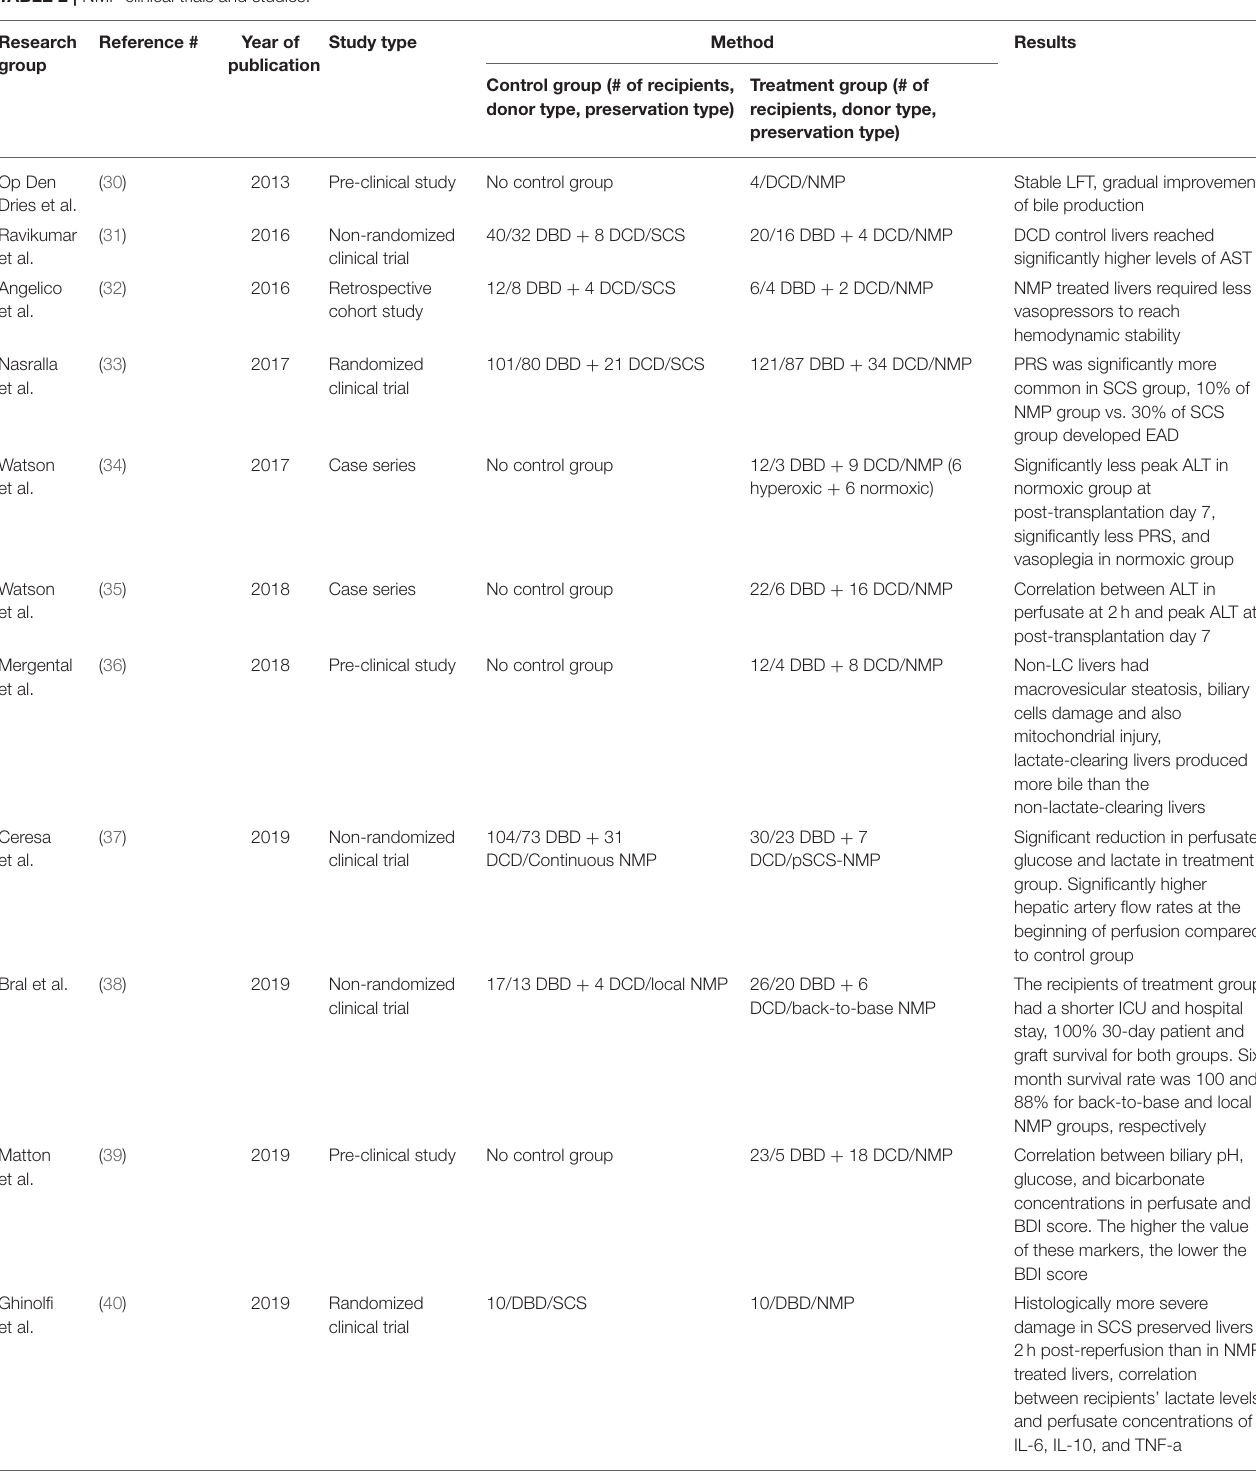
TABLE 2 | NMP clinical trials and